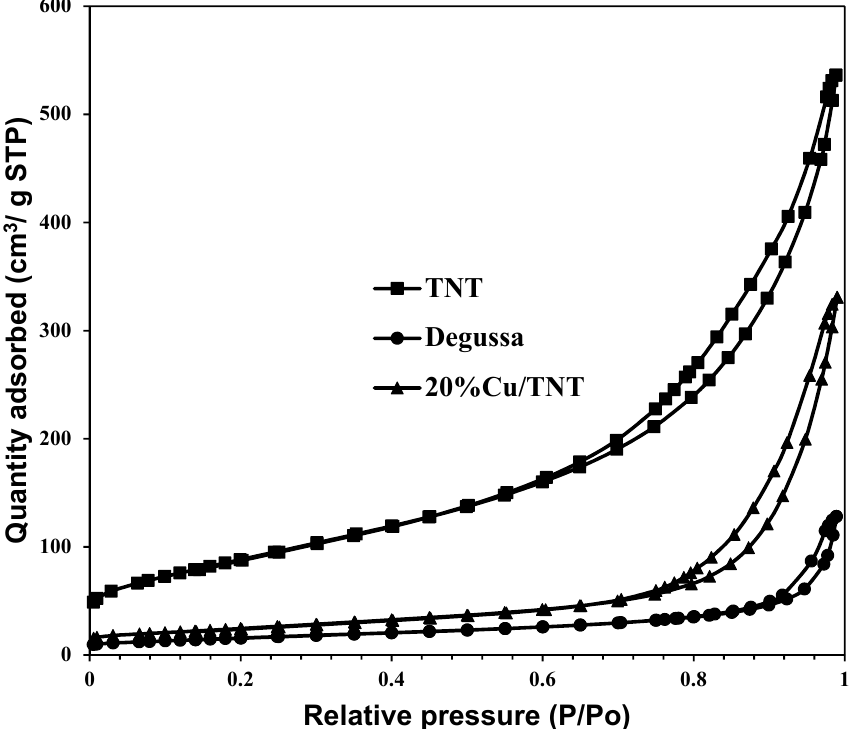
Figure 4. Nitrogen adsorption–desorption isotherms at 77 K for Degussa (P-25), TNT, and 20% Cu/TNT.